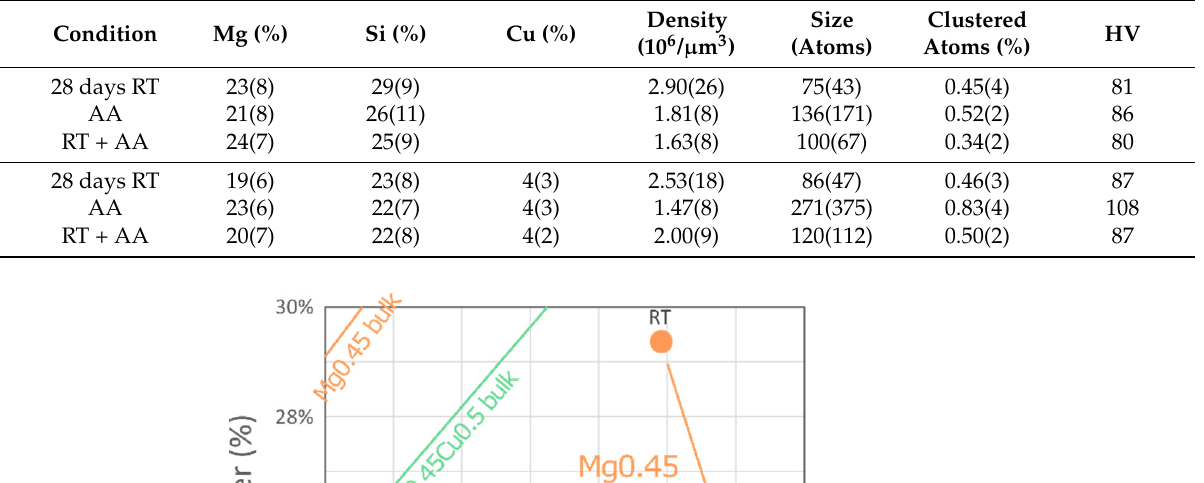
Table 3. Cluster parameters measured with APT. Average values, with standard deviations in parentheses. Percentages are atomic fractions (Al is in balance). The cluster size is given in number of atoms to avoid making assumptions about cluster shape. The clustered atoms value is the ratio of atoms (Al, Mg, Si, Cu) in clusters to total atoms in the volume (approximately equal to the cluster volume fraction). Vickers hardness (HV) is included for reference.